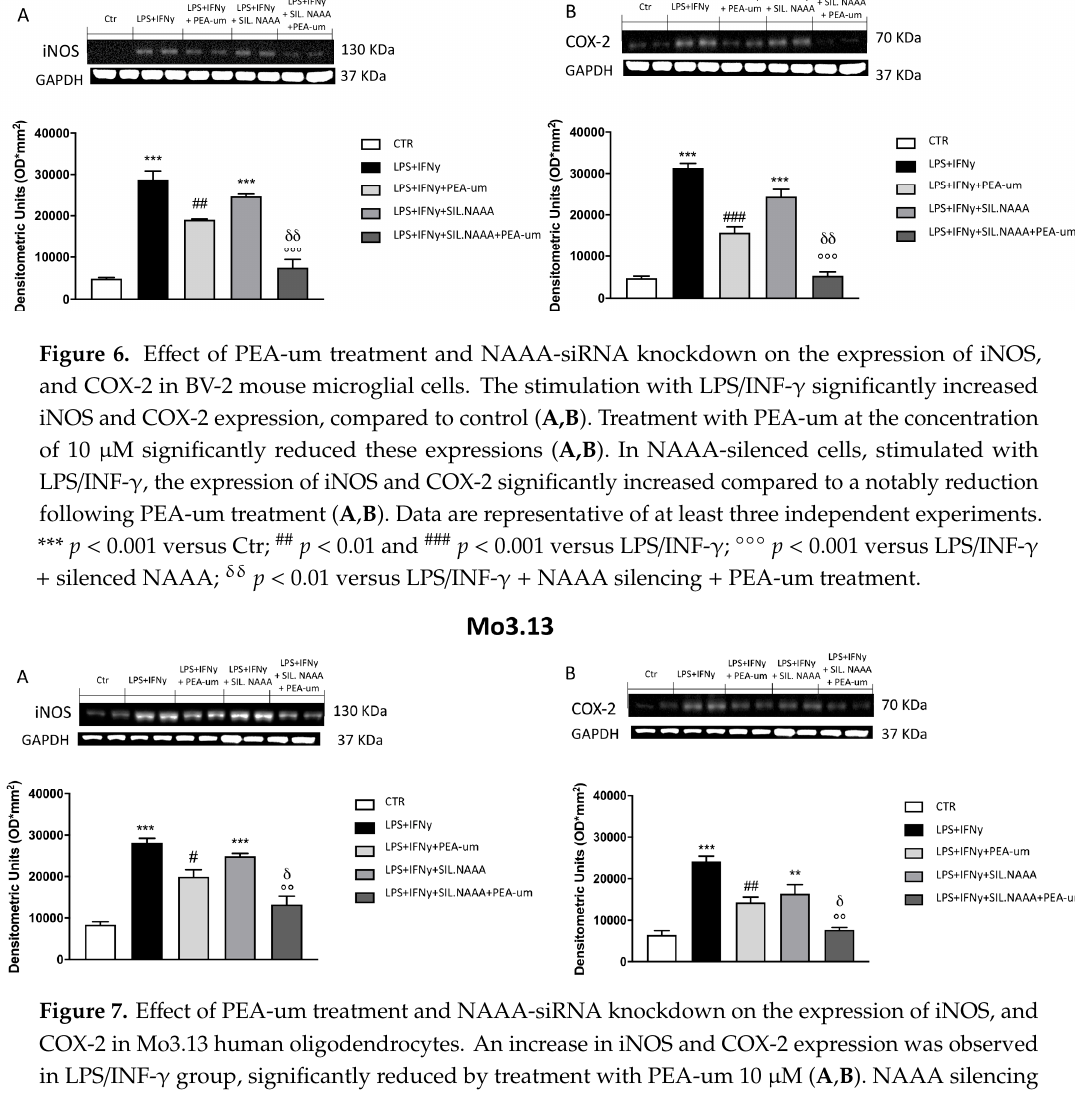
Figure 5. Effect of PEA-um treatment and NAAA-siRNA knockdown on the expression of iNOS, and COX-2 in SHSY-5Y human neuroblastoma cells. An increase in iNOS and COX-2 expression was observed in LPS/INF- γ group, significantly reduced by treatment with PEA-um at the concentration of 10 μ M ( A , B ). Blots revealed a significant increase of iNOS and COX-2 in LPS/INF- γ group, in which the cells were NAAA-silenced ( A , B ); treatment with PEA-um 10 μ M significantly reduced inflammatory markers expression in cells NAAA-silenced compared to only silenced cells or to only PEA-um treated cells ( A , B ). Data are representative of at least three independent experiments. *** p < 0.001 versus Ctr; # p < 0.05 and ### p < 0.001 versus LPS/INF- γ ; °° p < 0.01 and °°° p < 0.001 versus LPS/INF- γ + silenced NAAA; δ p < 0.05 versus LPS/INF- γ + NAAA silencing + PEA-um treatment.